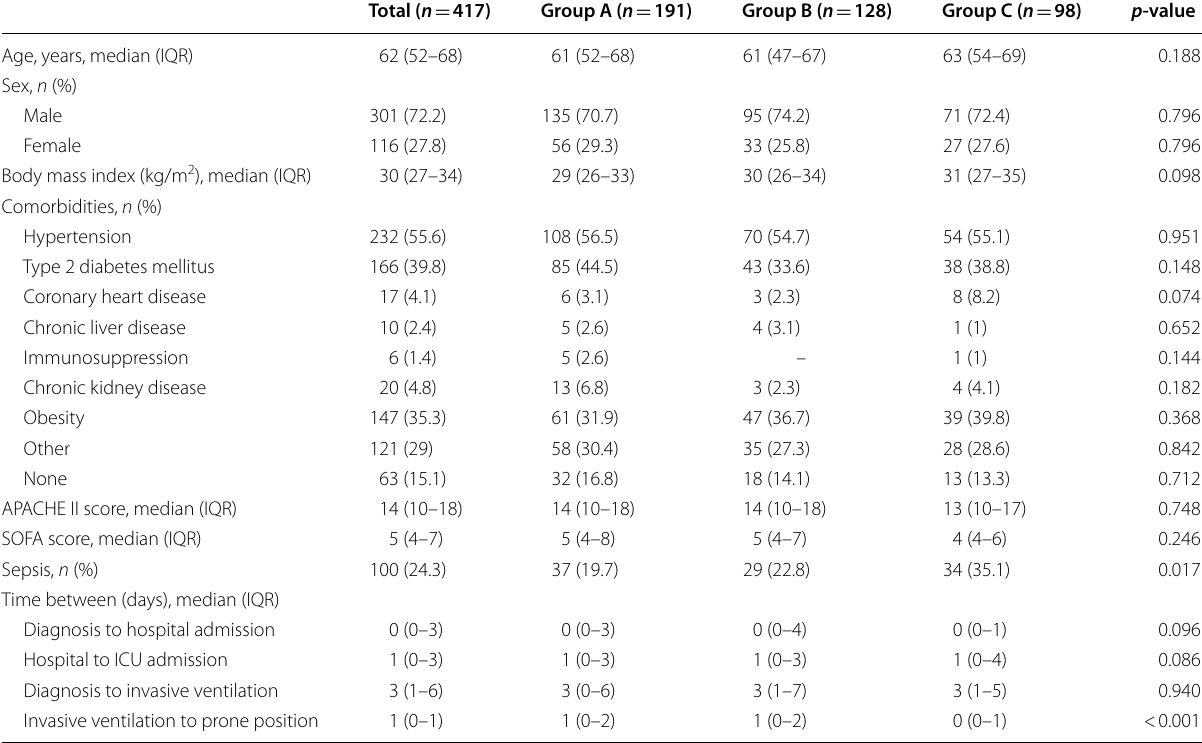
Table 1 Clinical characteristics at baseline according to the duration of the first prone